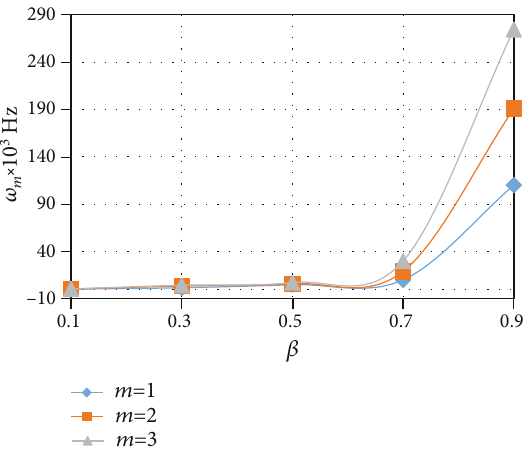
Figure 5: Variation of angular frequency and radius ratio of 2- layered annular circular plates. S-S.